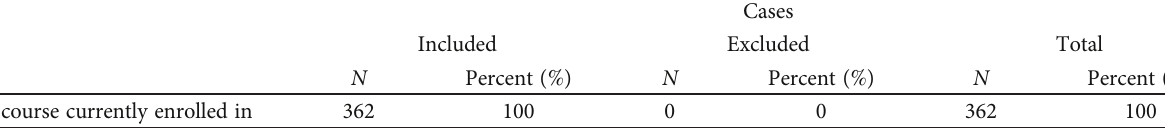
F IGURE 3: The hypothesized model. T ABLE 6: Case processing